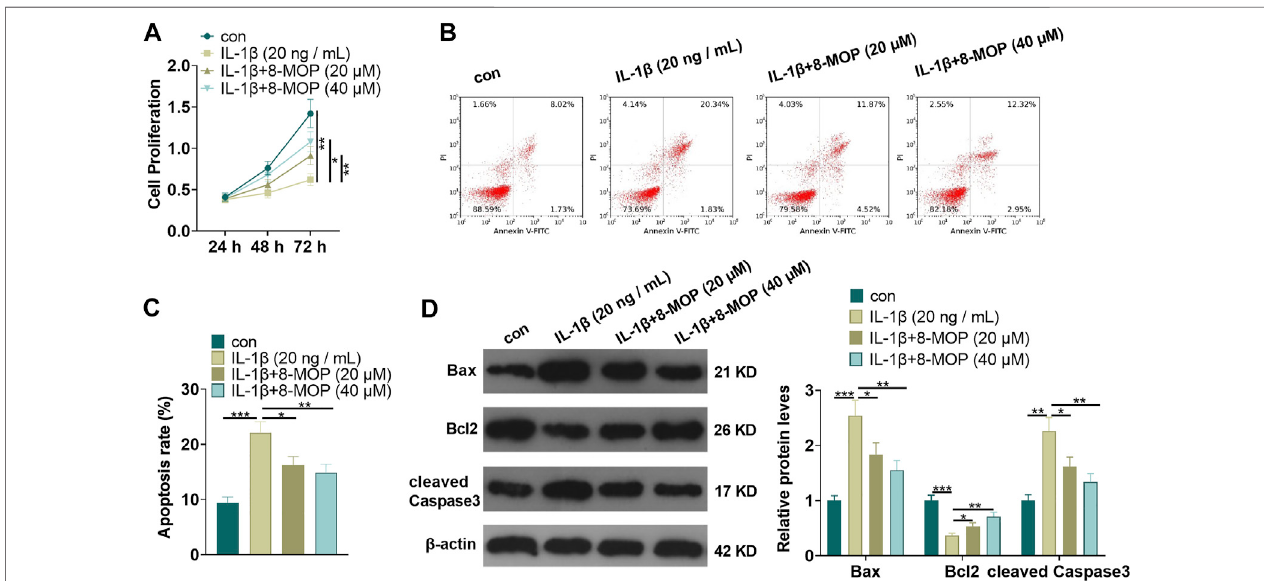
FIGURE 1 | 8-MOP attenuated IL-1 β -mediated cell apoptosis and proliferation inhibition. Rat chondrocytes were treated with IL-1 β (20 ng/ml) and/or 8-MOP (20 and40 µM)for24 h. (A – C) ,MTTandFCMwereappliedtomonitorcellproliferationandapoptosis,respectively. (D) ,Westernblotwasutilizedtomeasuretheexpression of apoptotic related proteins, including Bax, Bcl2, and cleaved Caspase3. * p < 0.05, ** p < 0.01, *** p < 0.001. ( n (cid:1) 3).